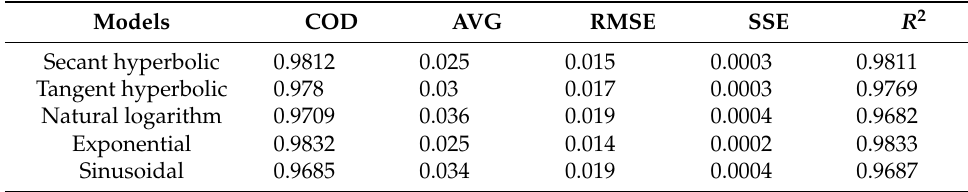
Table 10. Precision and performance of models for CSR prediction (all